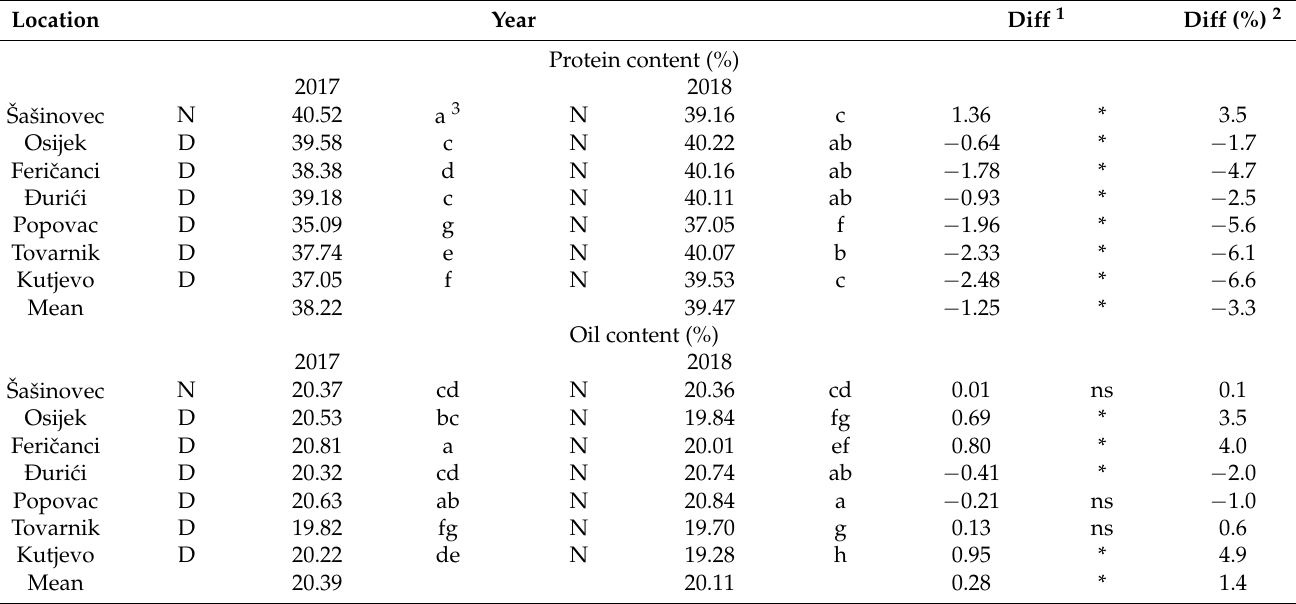
Table 4. Mean protein and oil contents of 32 soybean genotypes at seven locations in 2017 and 2018 growing